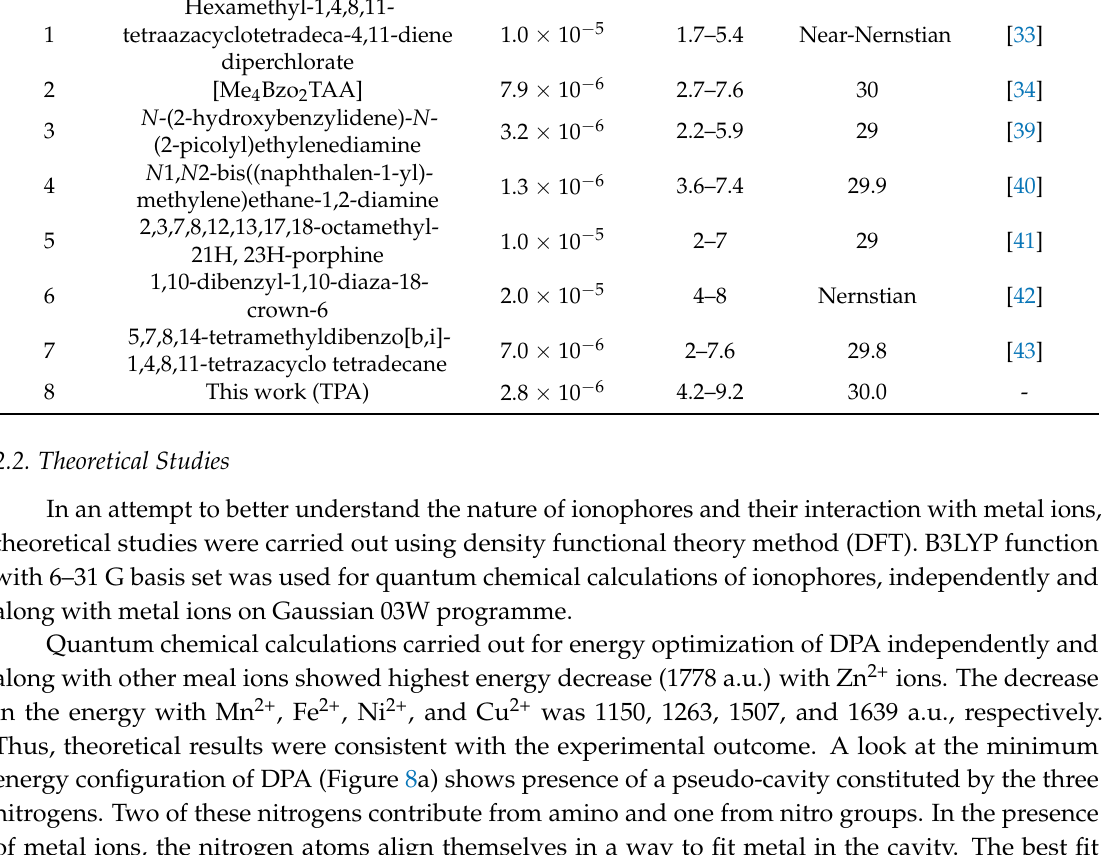
Table 6. Comparison of proposed TPA-based Ni 2+ selective electrode with the reported electrodes. S. No.